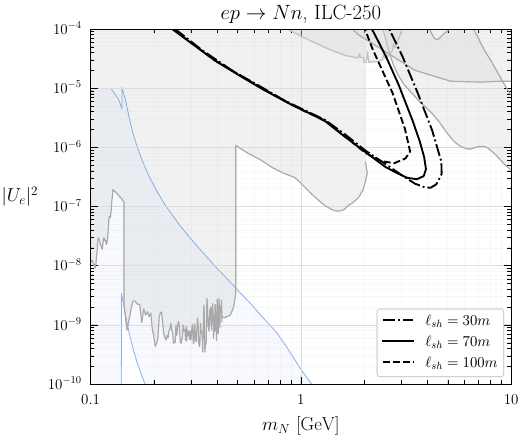
Figure 8 . Variation of the bound on an electron-mixed HNL parameter space for different lengths of the muon shield ‘ (fixing the distance to the dump ‘ sh energy of the beam, 125 GeV). For the purpose of the plot, we only consider the charged-current production of electron-mixed HNLs for